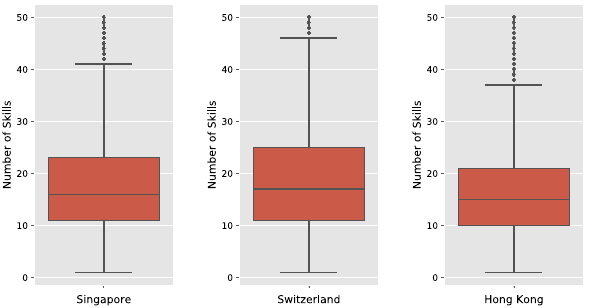
Fig. 5 Distribution of number of